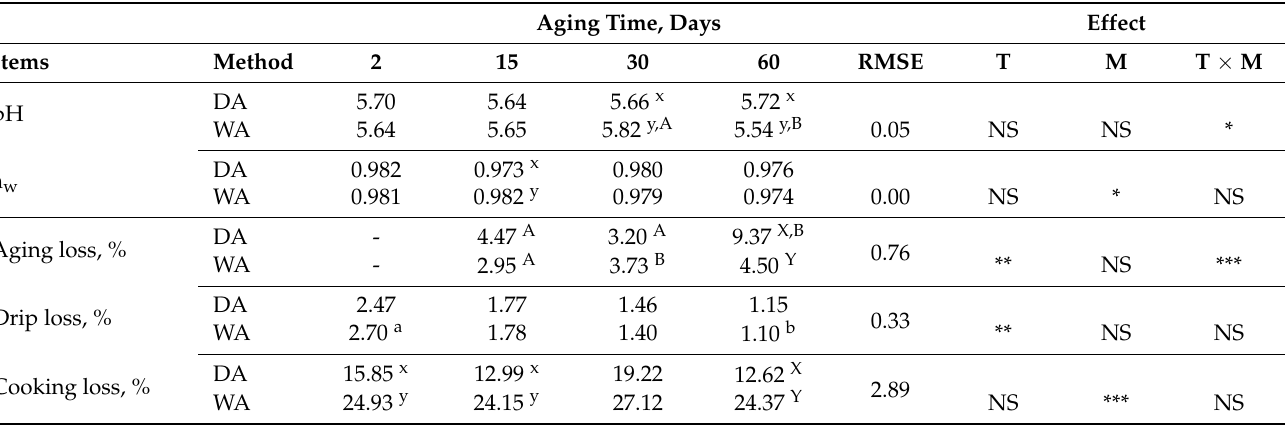
Table 2. Effect of time and method of aging on some physical features of Charolais meat cuts ( Longissimus dorsi (LD) and Semitendinosus (ST)) aged by different methods (dry-aging (DA) and wet-aging (WA)) for 60